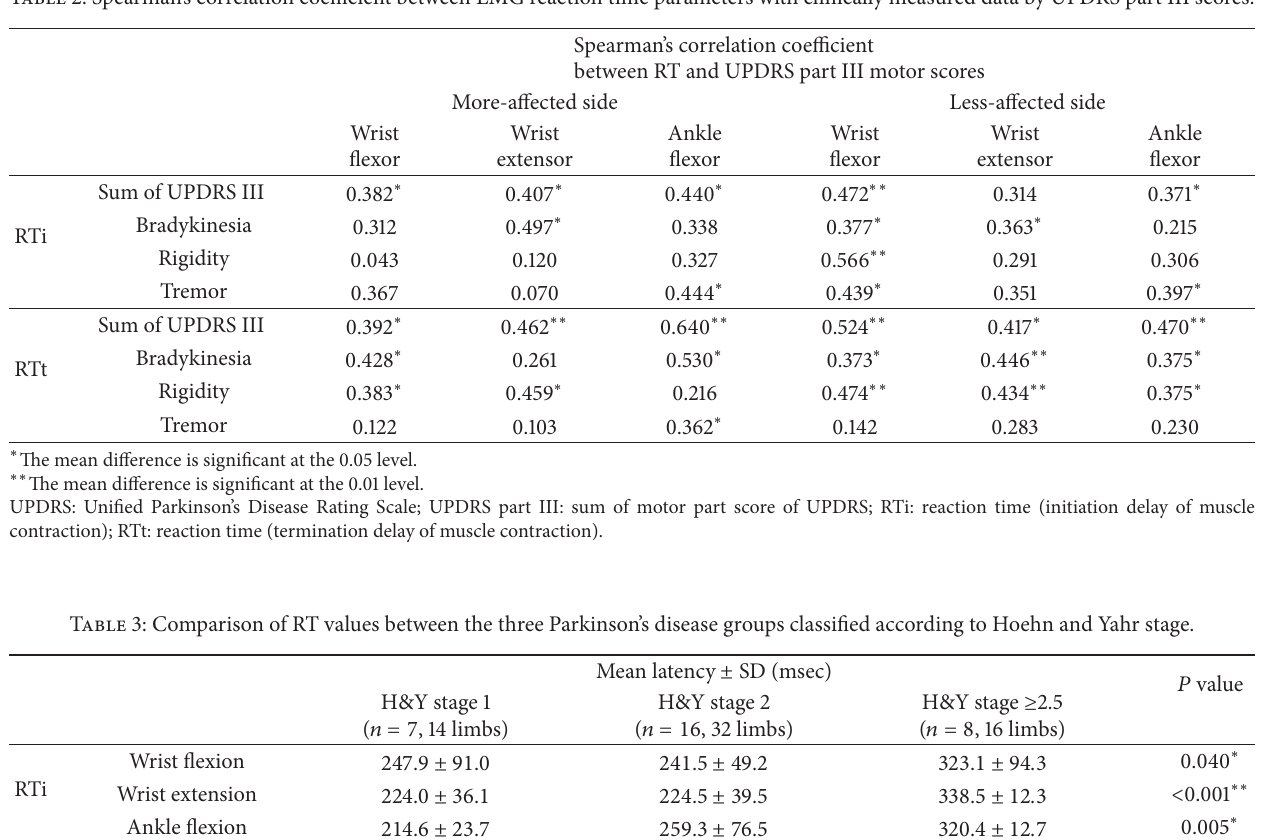
Table 2: Spearman’s correlation coefficient between EMG reaction time parameters with clinically measured data by UPDRS part III scores.